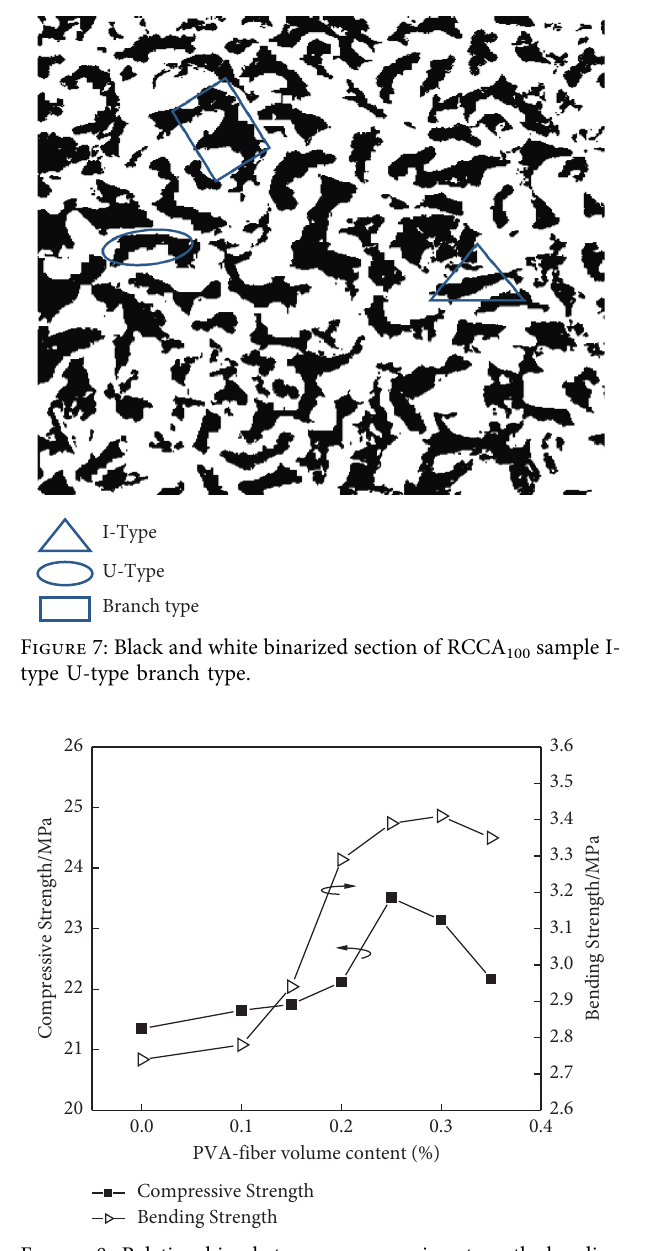
Figure 8: Relationships between compressive strength, bending strength, and PVA-fiber volume.